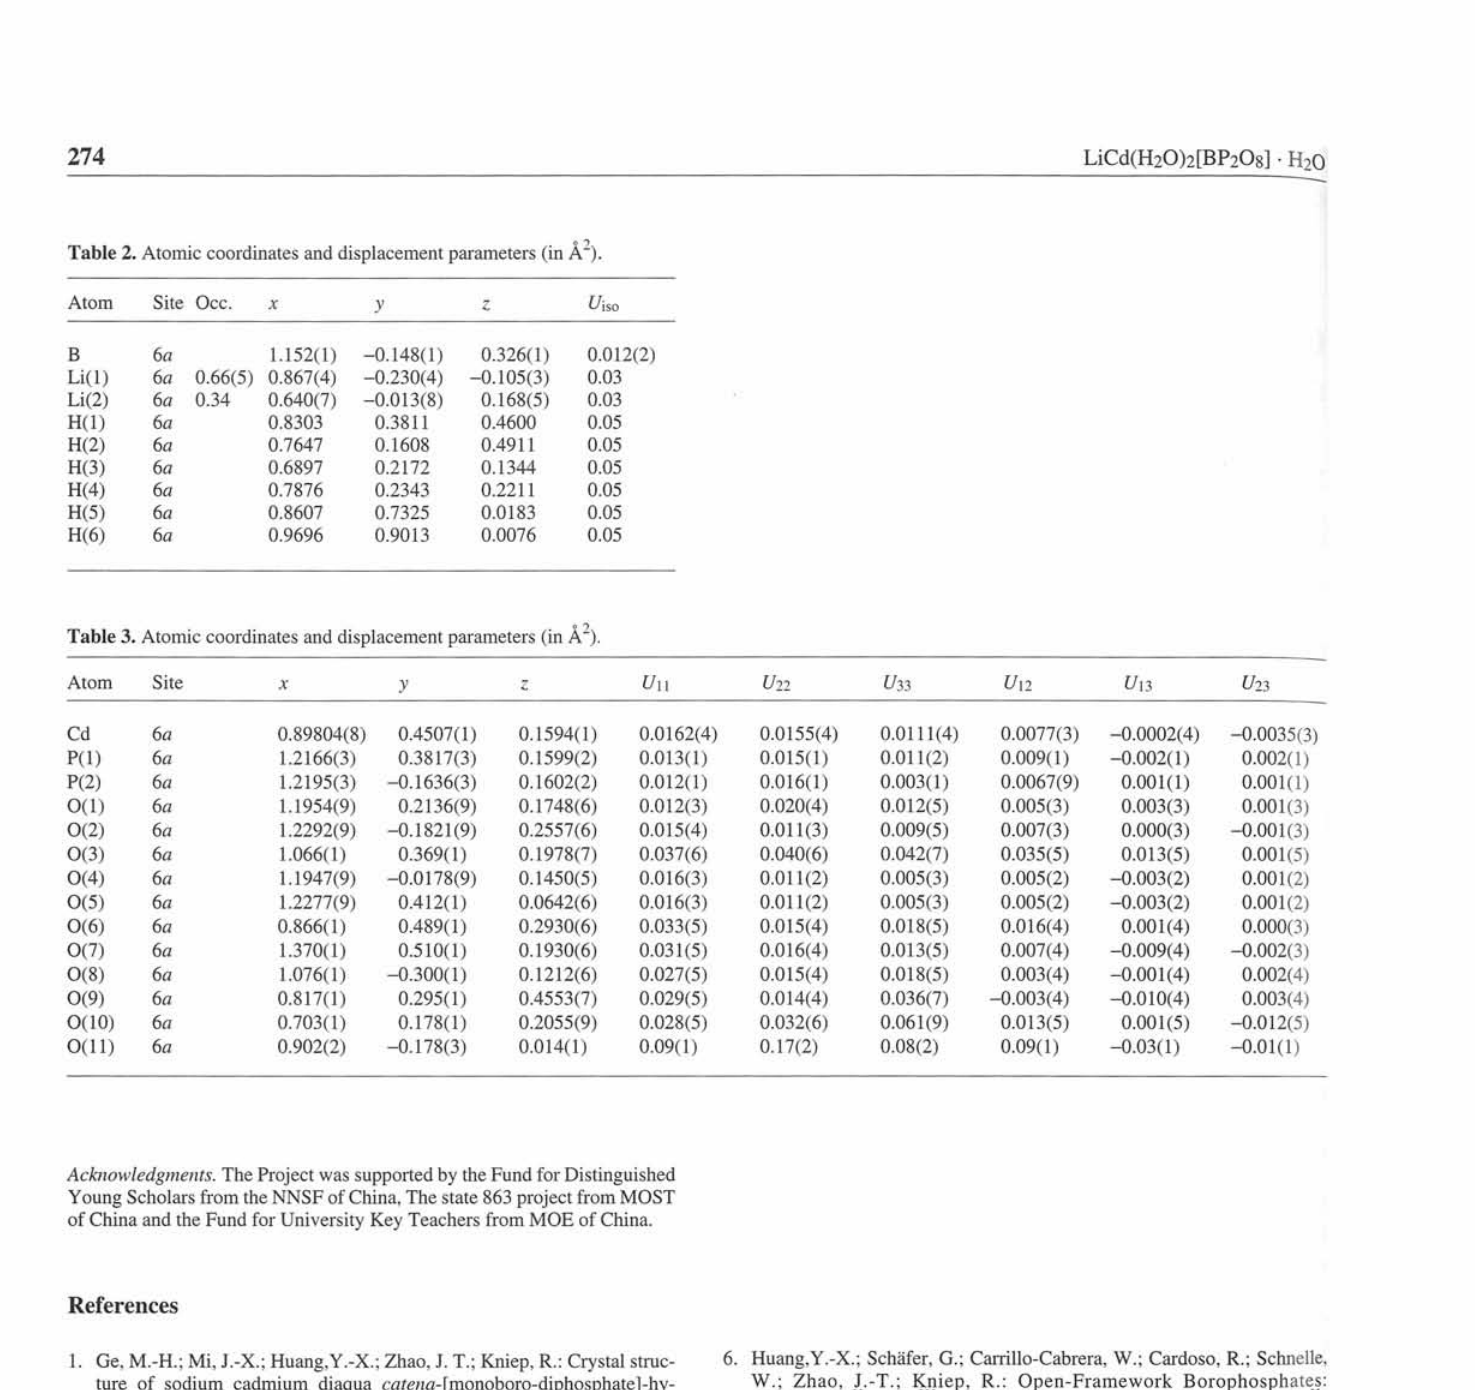
Table 2. Atomic coordinates and displacement parameters (in Â 2 ).